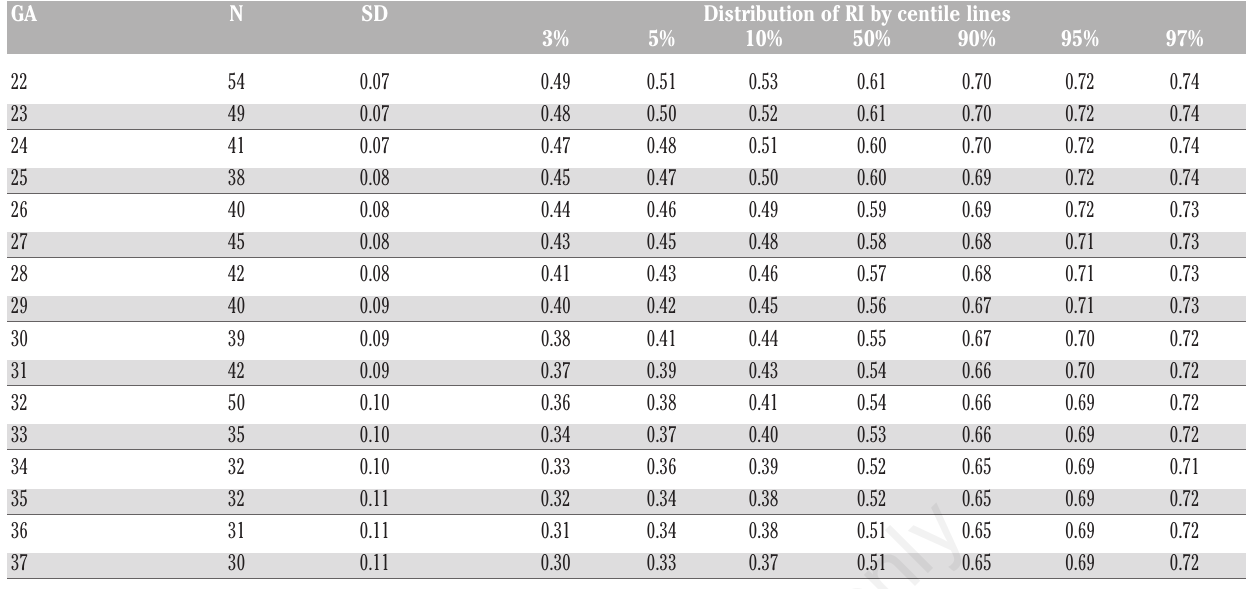
Table 3. RI values corresponding to the centile lines from 22-37 weeks: 3, 5, 10, 50, 90, 95, 97 for gestational age. GA